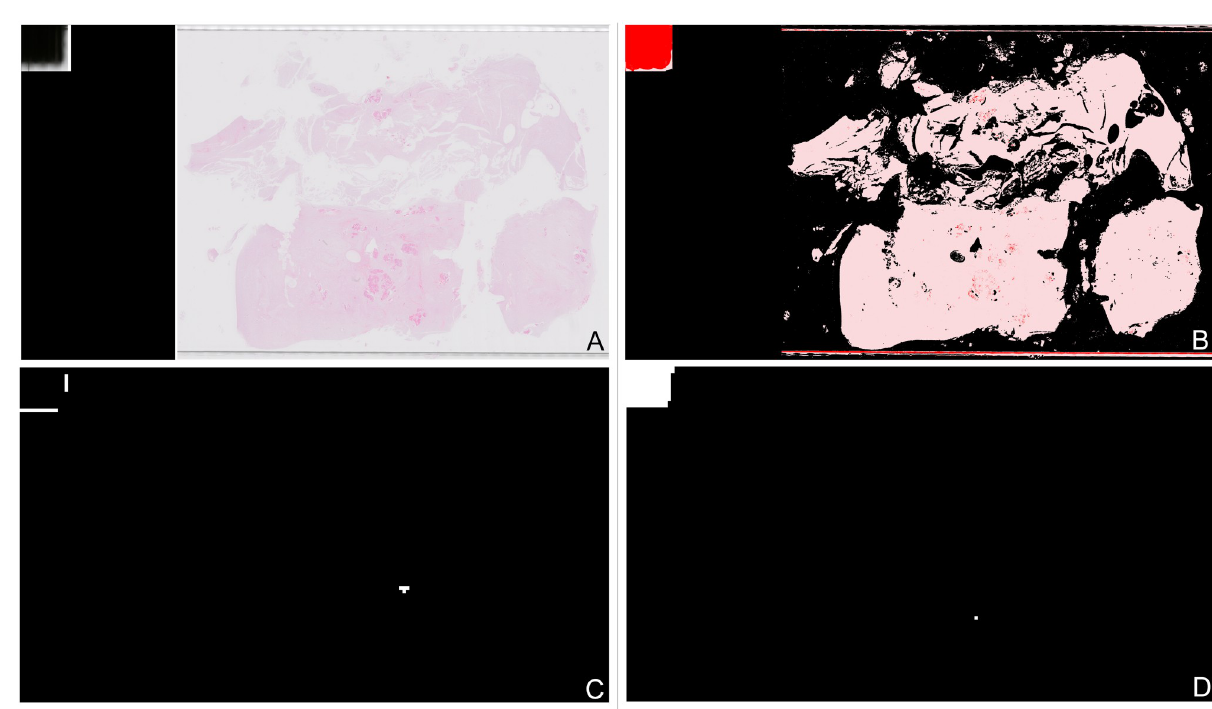
Fig 16. Example of a slide where a tissue detection problem gives an incorrect slide classification, “malignant” slide is classified as “other or benign”. (A) Thumbnail showing slide with small fragments of tissue. (B) Mask showing incorrect area of tissue detection in top left corner of slide. (C) Mask showing “malignant” segments used to extract slide features, two incorrect segments shown in top left. (D) Mask showing “other or benign” segments used to extract slide features, one very large incorrect segment shown in top left.